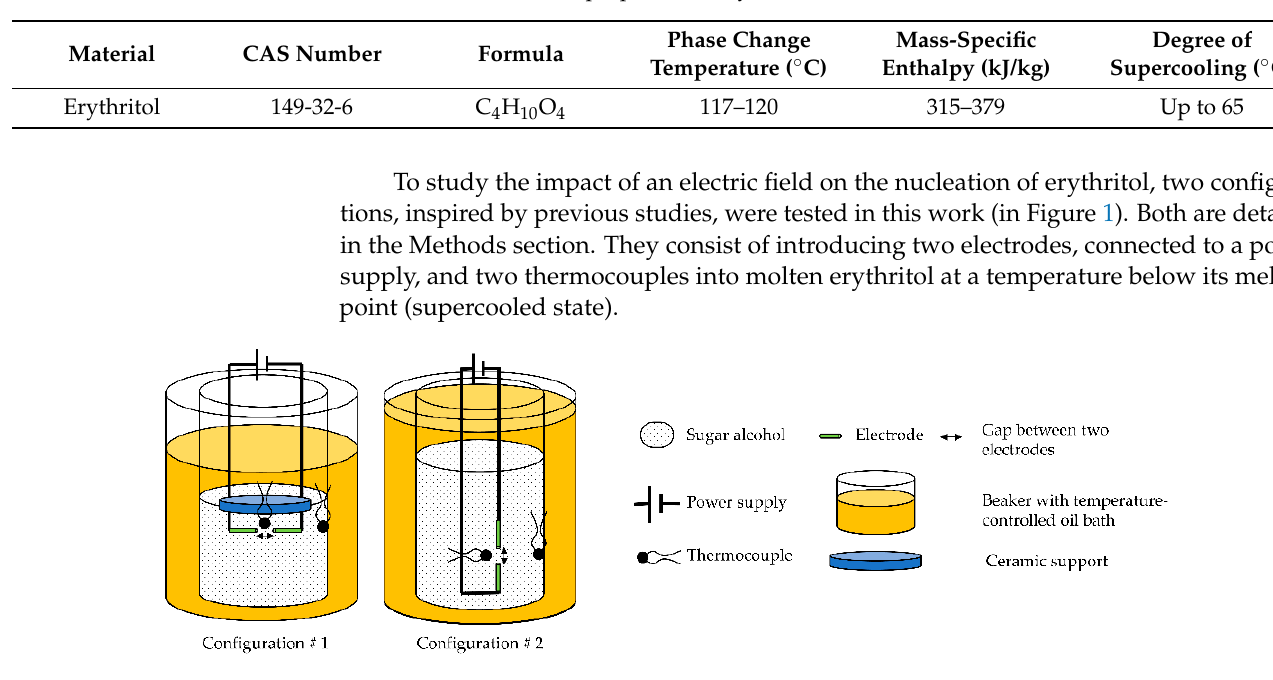
Table 1. Main properties of erythritol [19,20].